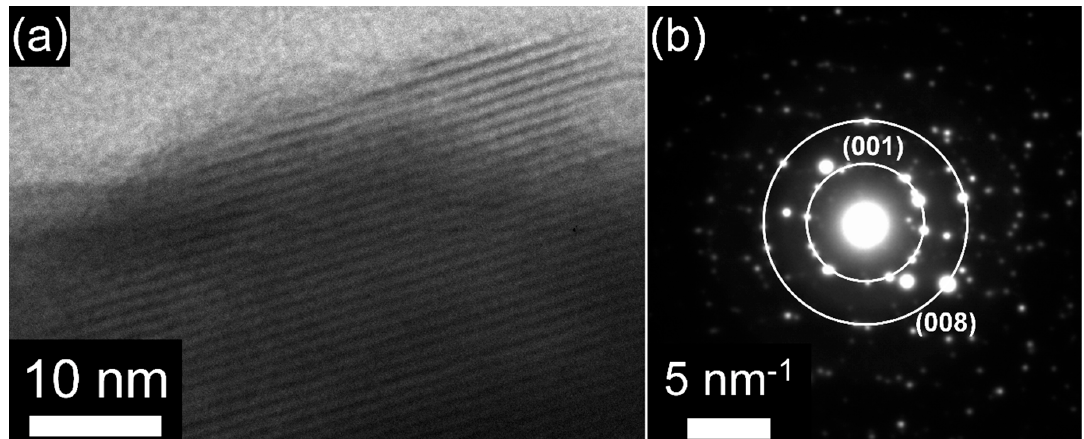
Figure 2. TEM images of a ( a ) nanosheet edge and of the ( b ) Selected Area Electron Diffraction (SAED) pattern for WSe 2 nanosheets.